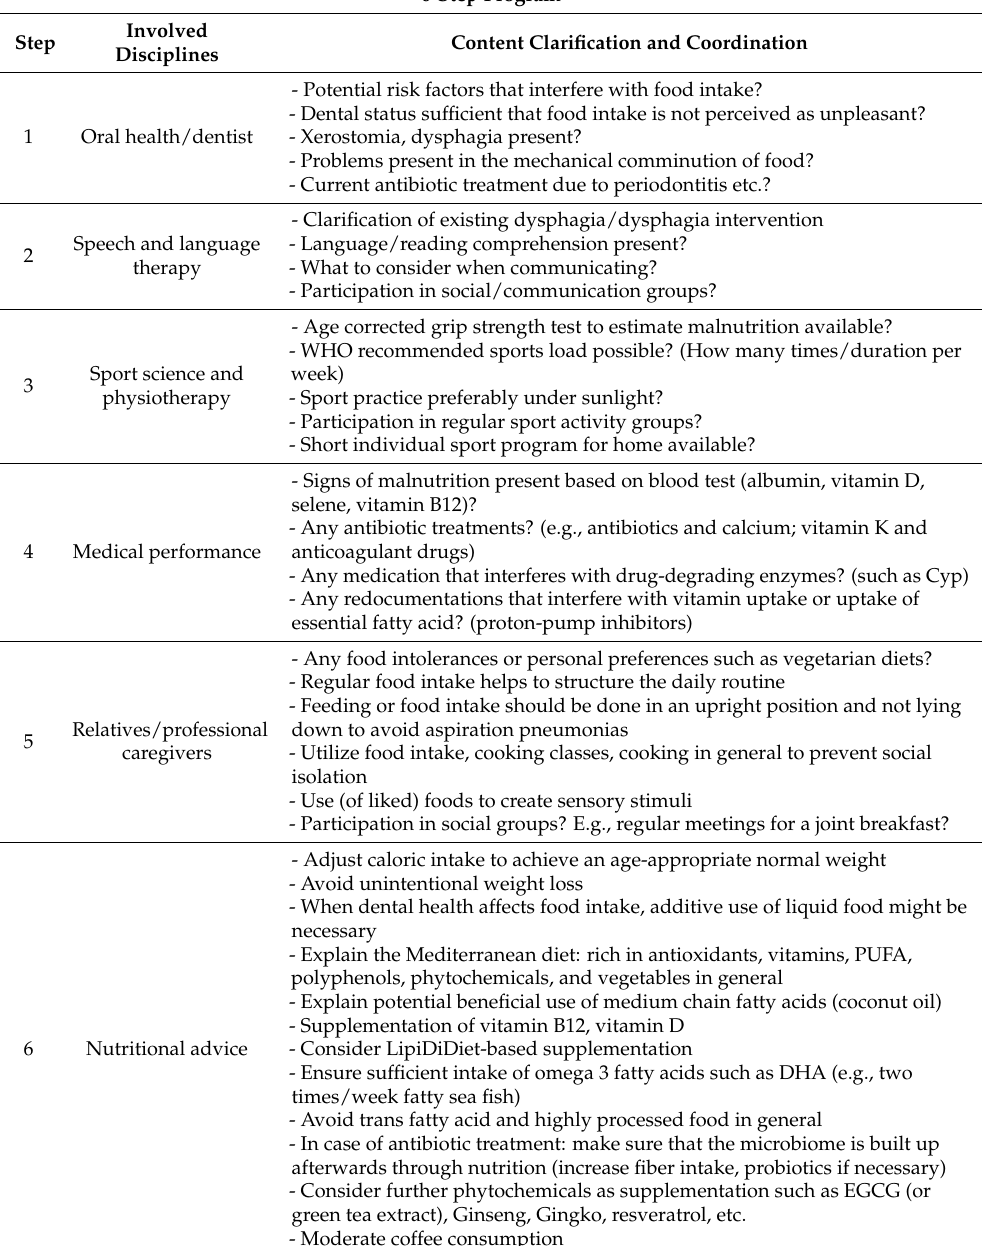
Table 3. Nutritional Intervention: A suggested 6-step program for nutritional